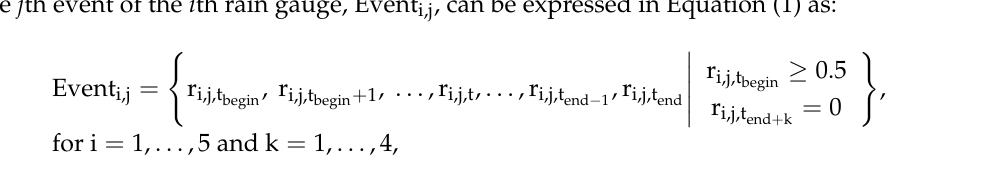
Figure 7. Rainfall events and inter-event time (IET).